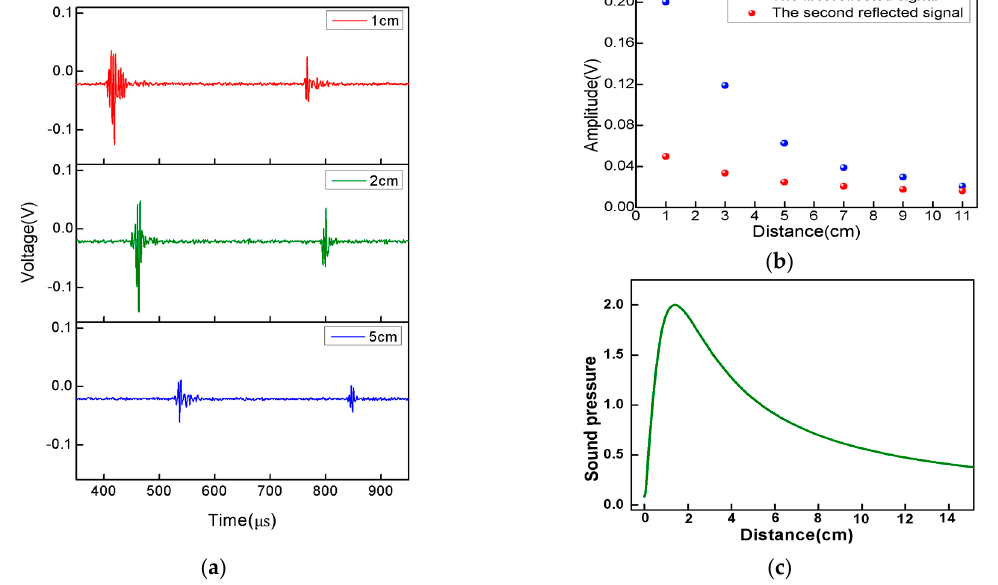
Figure 9. ( a ) Sensor response to a one-cycle 1 MHz ultrasonic pulse with different distances between the sensor and PZT (1 cm, 2 cm, and 5 cm, respectively); ( b ) the amplitude of the reflected signal versus distance; ( c ) the sound pressure distribution of PZT.